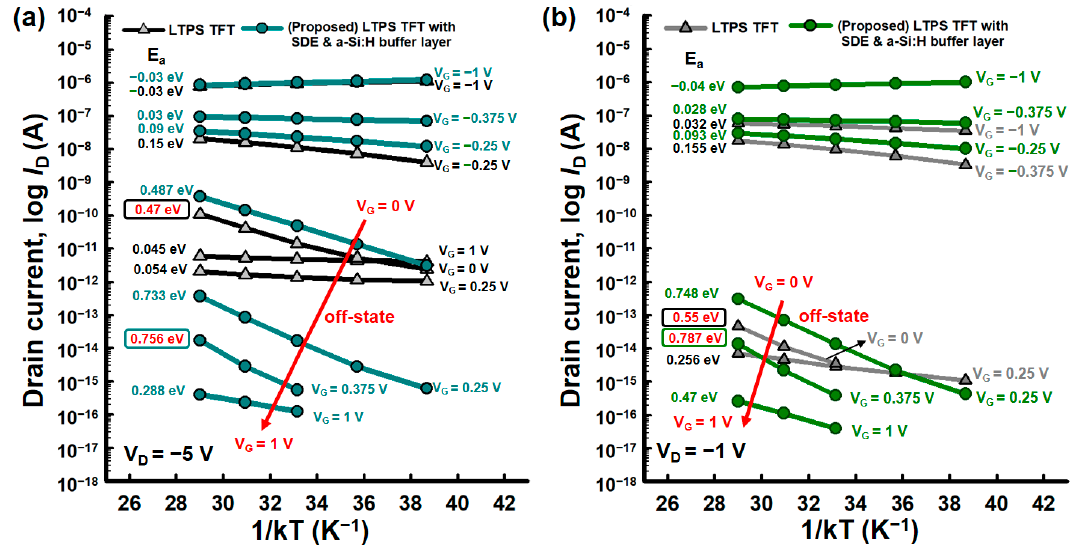
Figure 7. Arrhenius plots ( I D -1/kT) as a function of V G for T (300, 325, 350, 375, 400 K): ( a ) at V D = − 5 V; and ( b ) at V D = − 1 V. The slopes of each line indicate E a ’s.